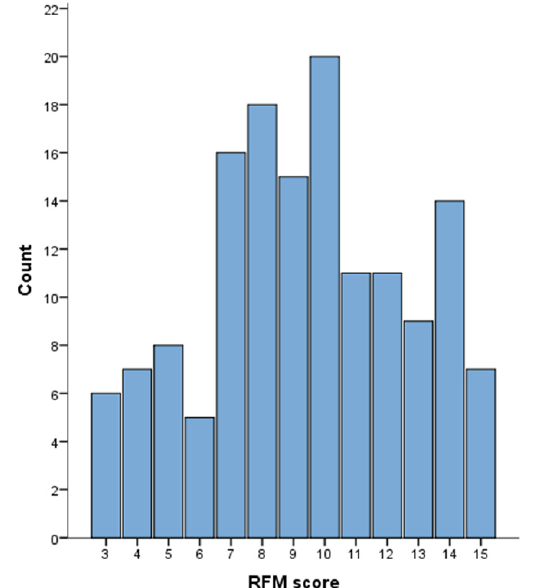
Figure 2. Distribution of the Recency, Frequency, Monetary value (RFM) score in the whole study population ( n = 147).